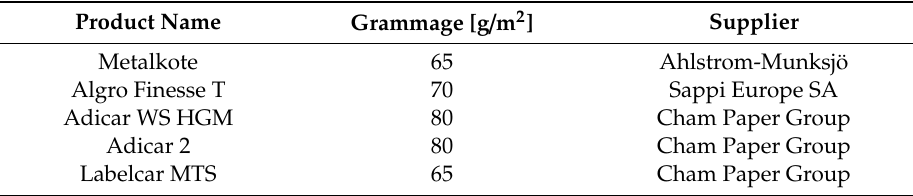
Table 1. Paper and polymer